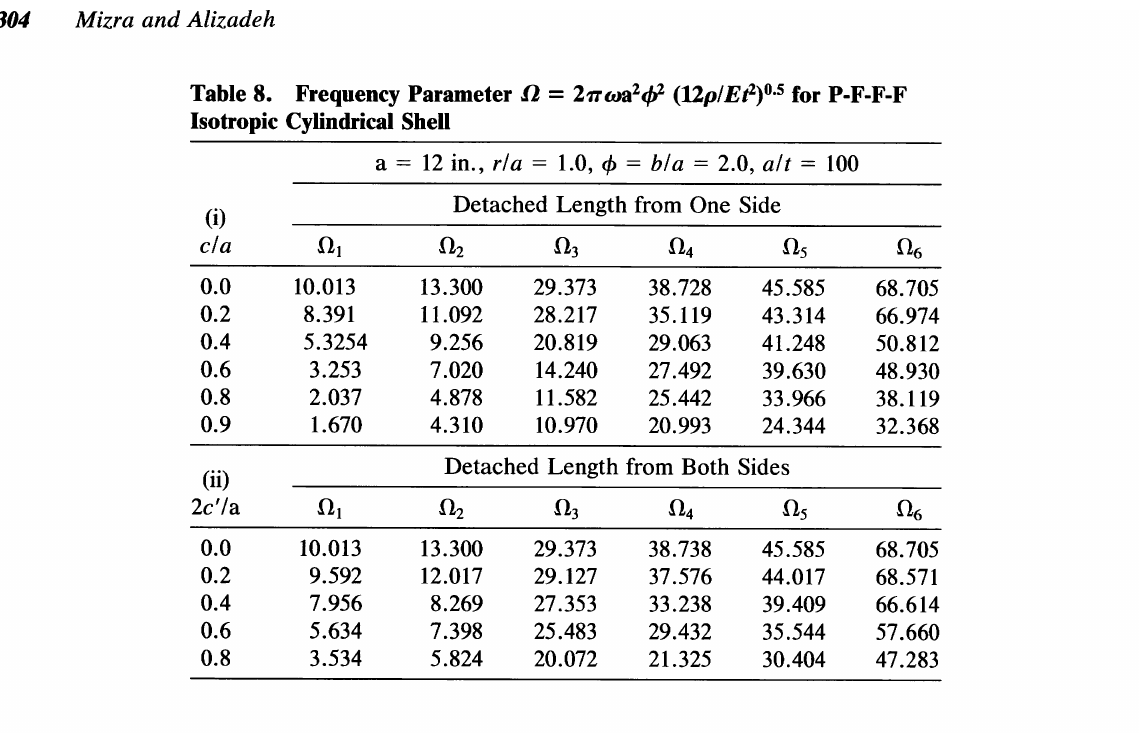
= 2'TTwa z 4JZ (UpIEP)O.5 for P-F-F-F